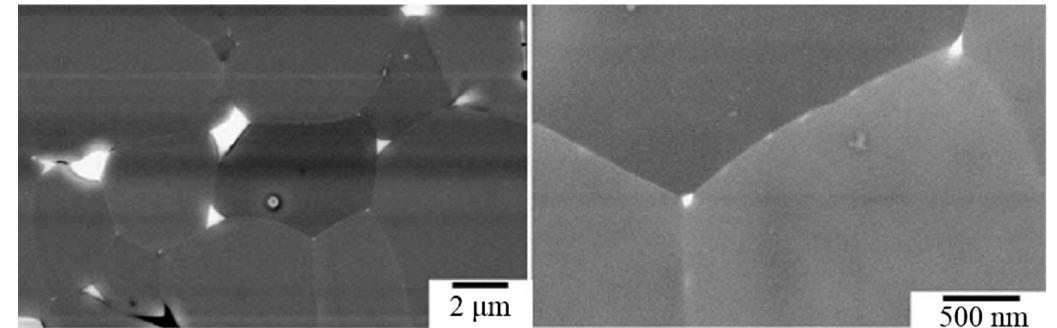
Figure 5. SEM images of NdFeB permanent magnets [59]; published by Elsevier, 2004.